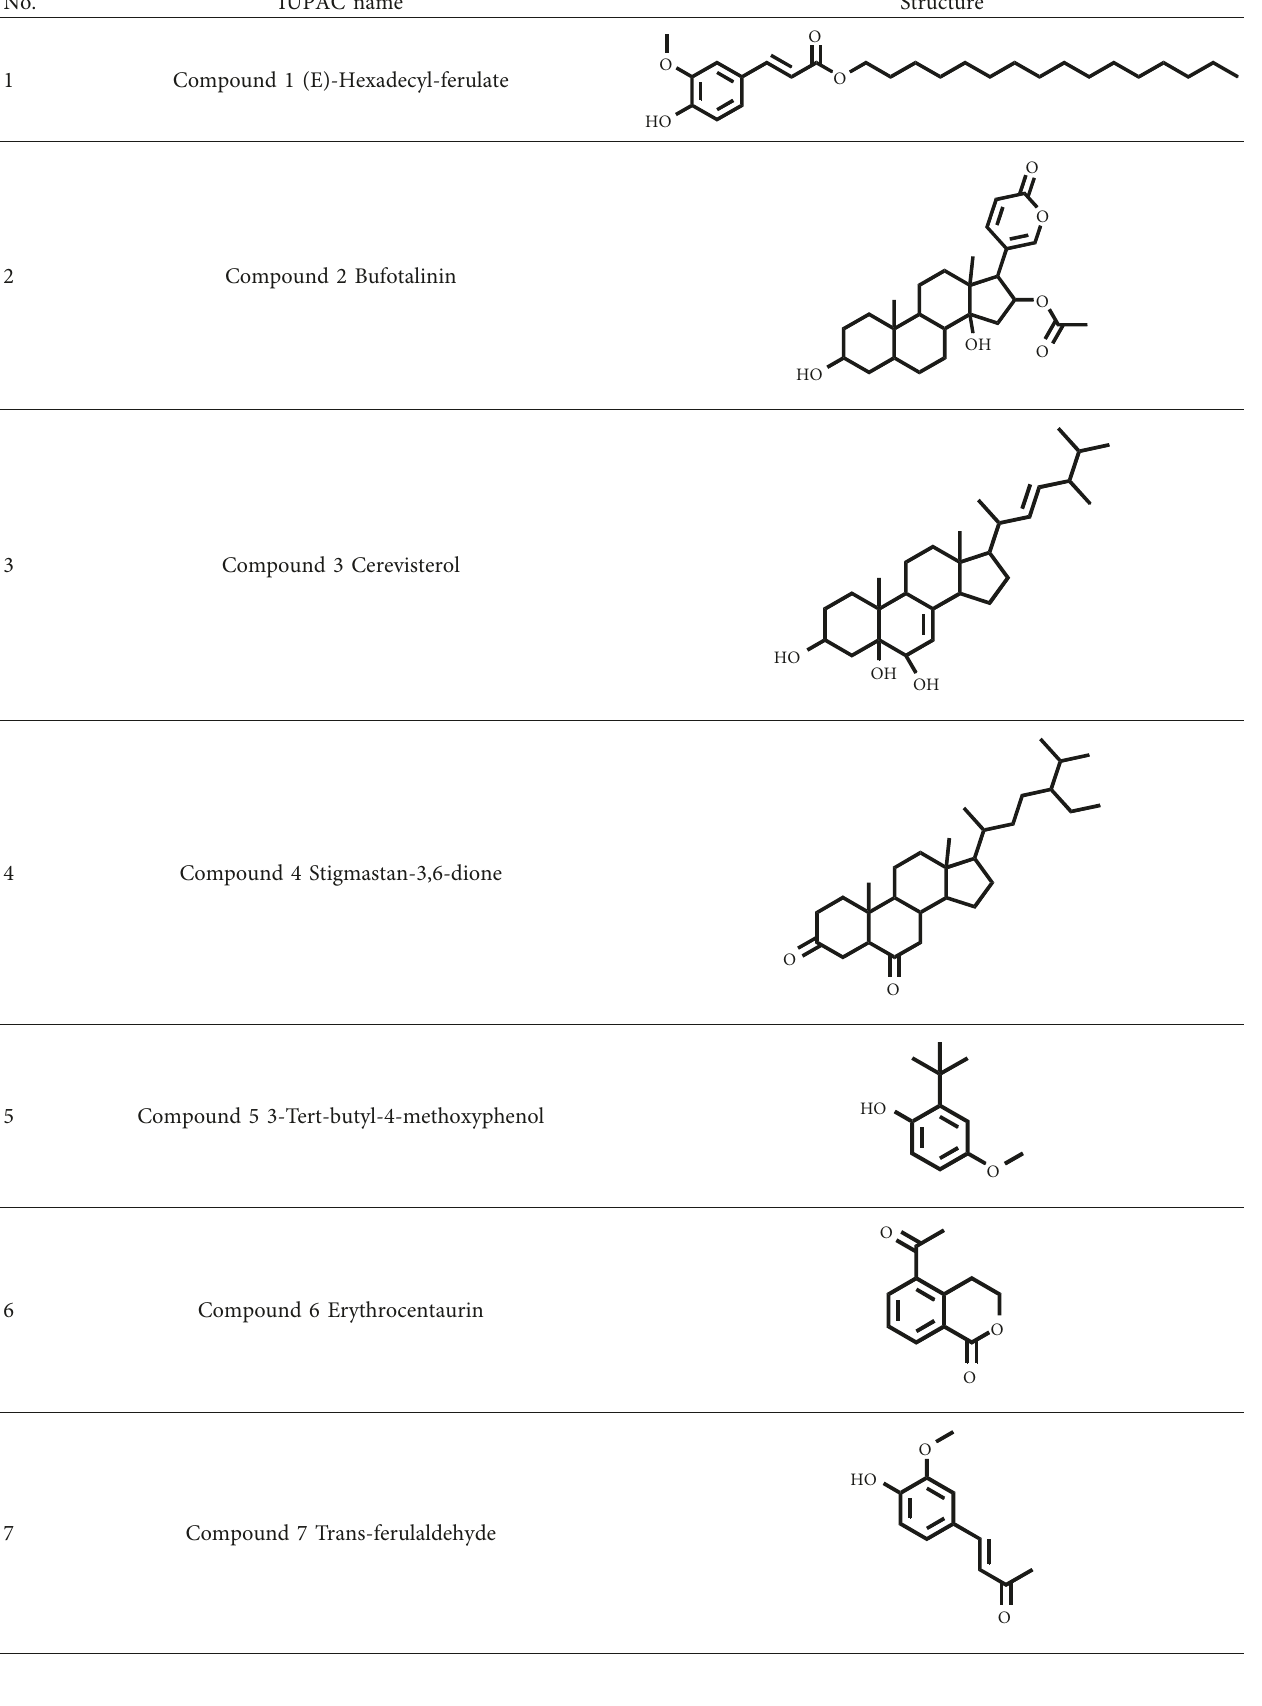
Table 1: Two-dimensional structure of minoxidil, finasteride, and assay ligands from purified M. peltata leaf extract.